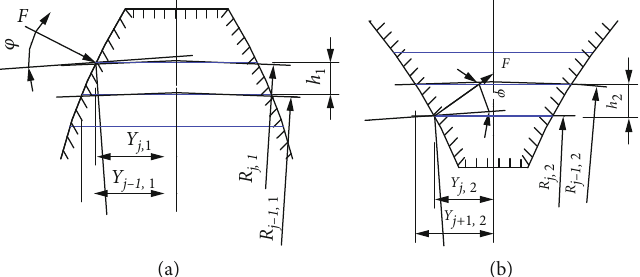
Figure 6: Schematic diagram of the loaded involute spline coupling of aeroengine under ideal conditions: (a) schematic diagram of the loaded external spline; (b) schematic diagram of the loaded internal